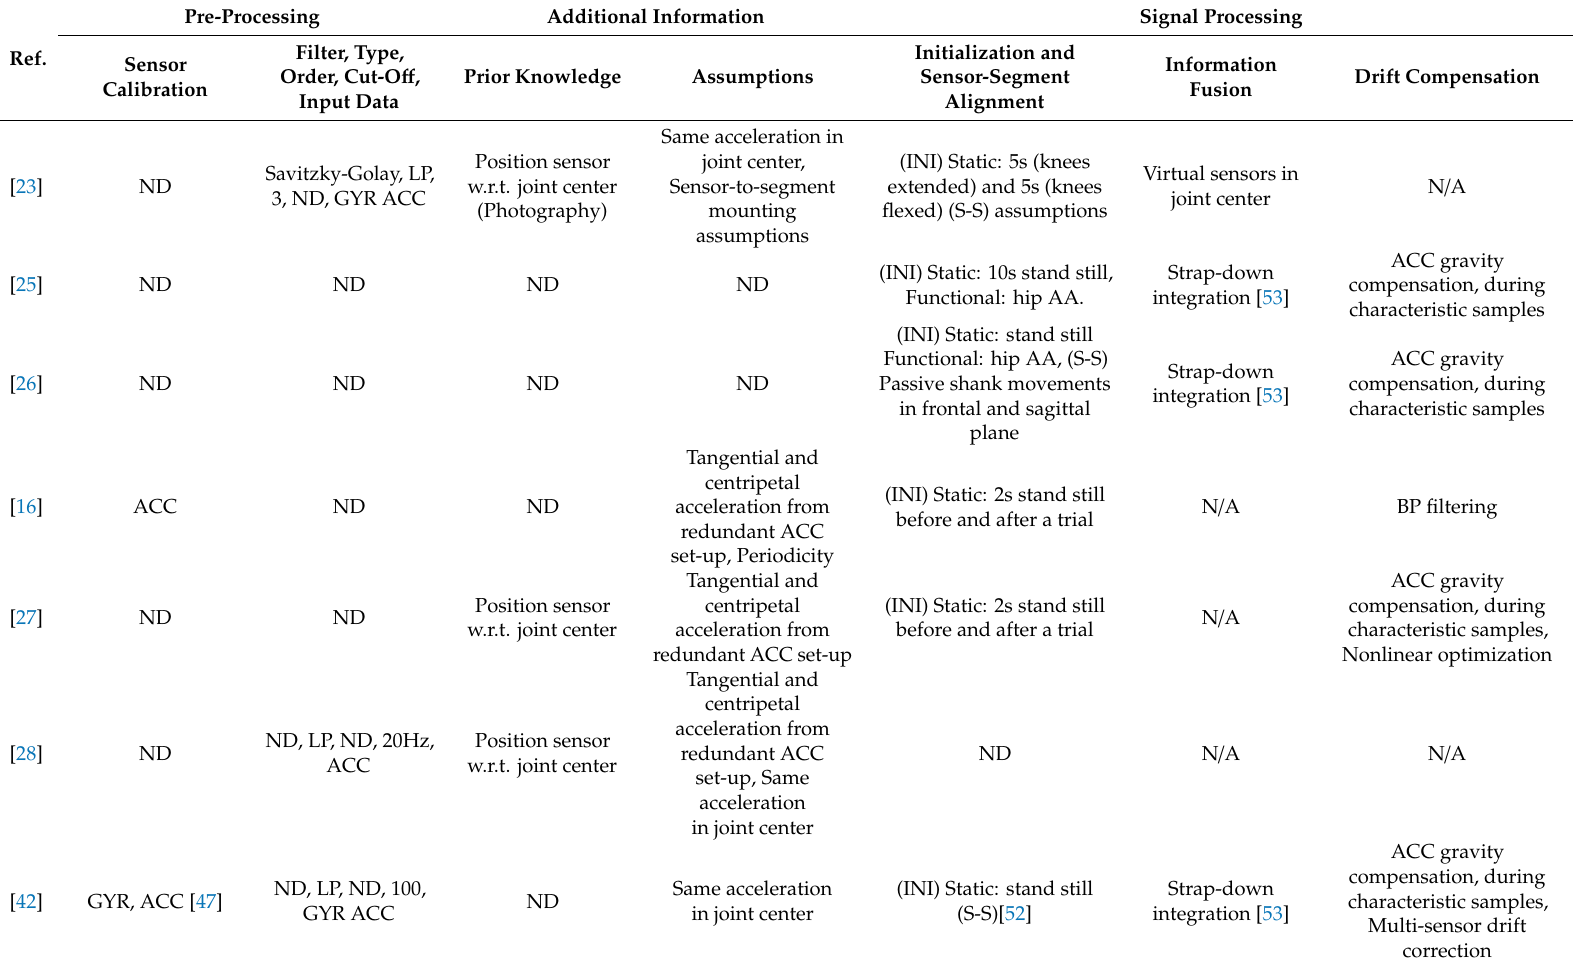
Table 2. Signal processing